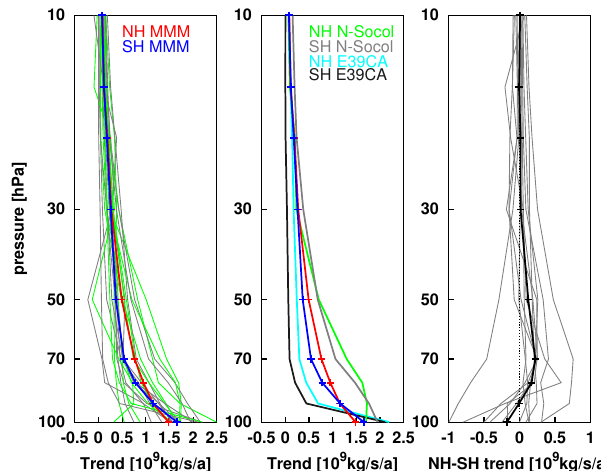
Fig. 6. Profiles of trends in the annual mean residual circulation total downward mass flux in each hemisphere over 1960 to 2049, individual models and multi-model mean color-coded as in Fig. 4. Right: difference NH − SH downward mass fluxes for the multi- model mean (black) and individual models (grey lines).